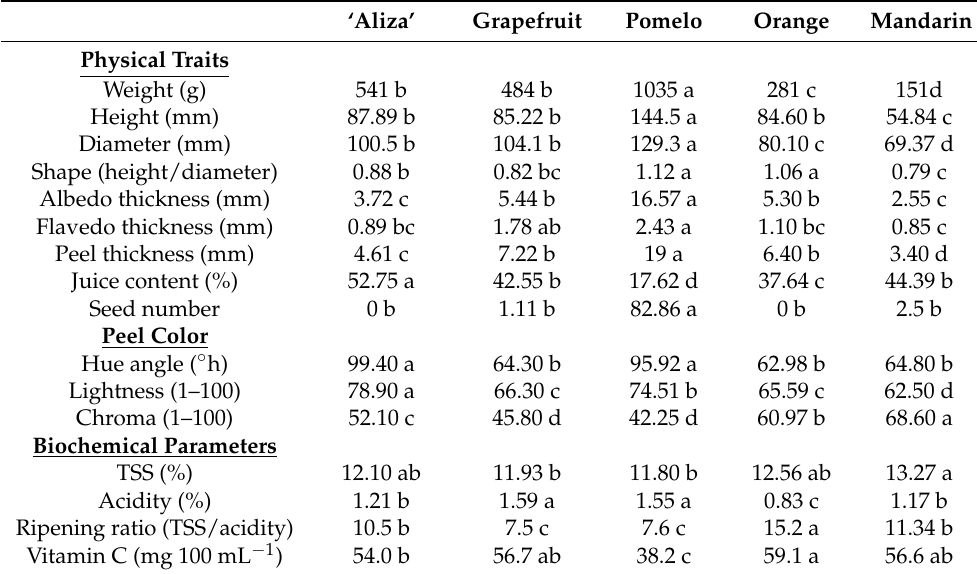
Table 1. Fruit quality traits of different citrus fruits. ‘Aliza’ Grapefruit